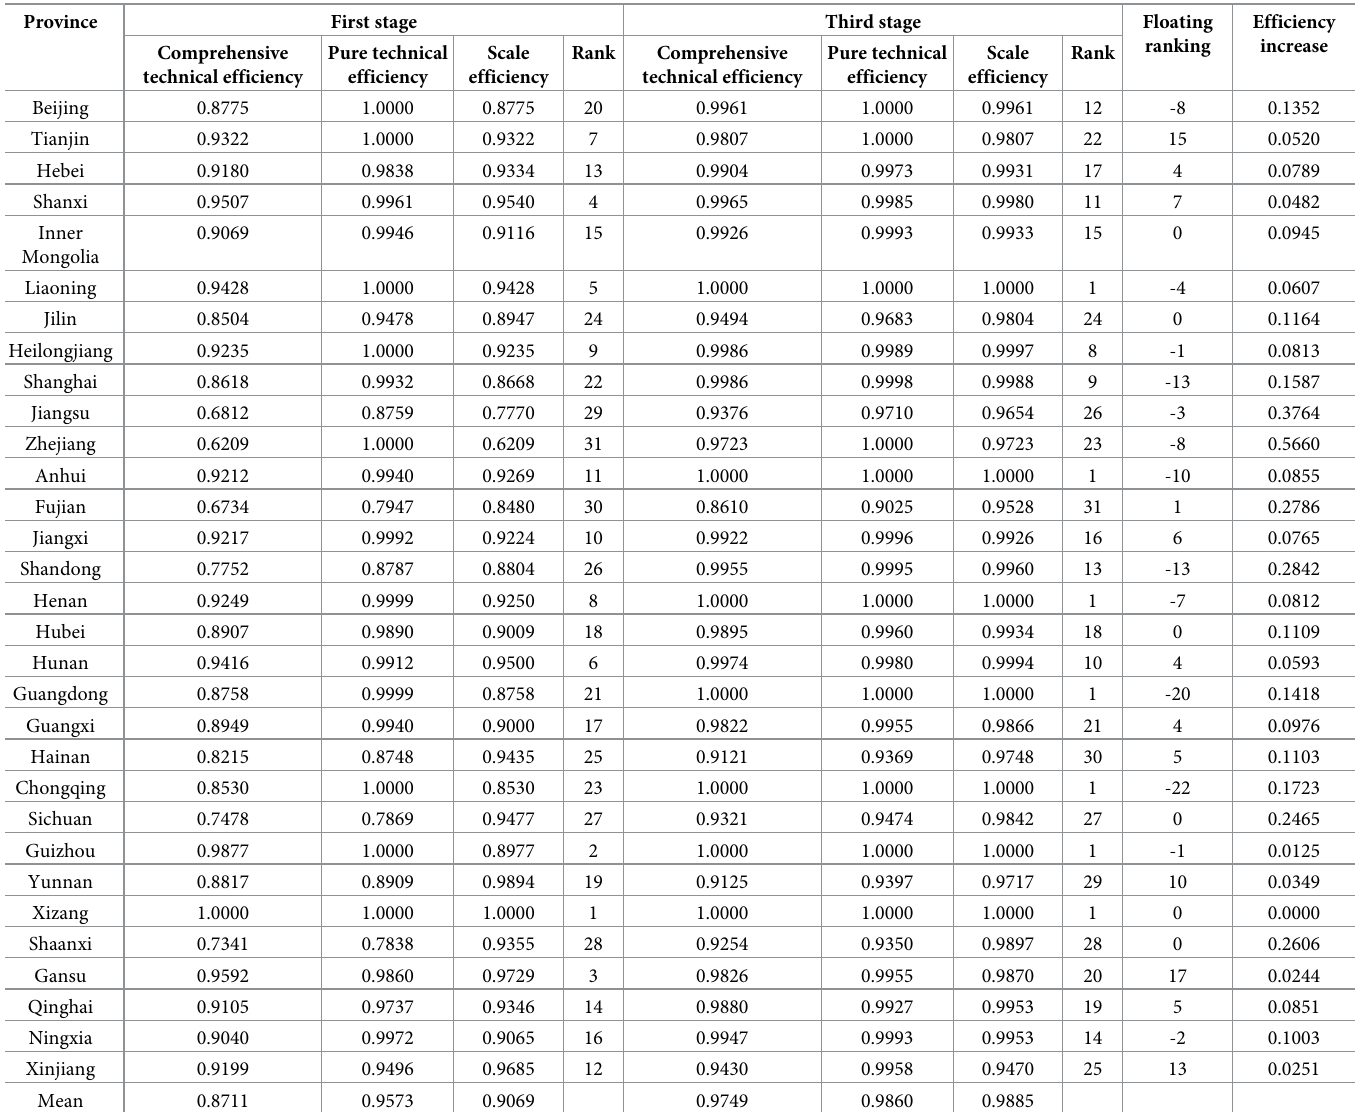
Table 2. First-stage and third-stage efficiency